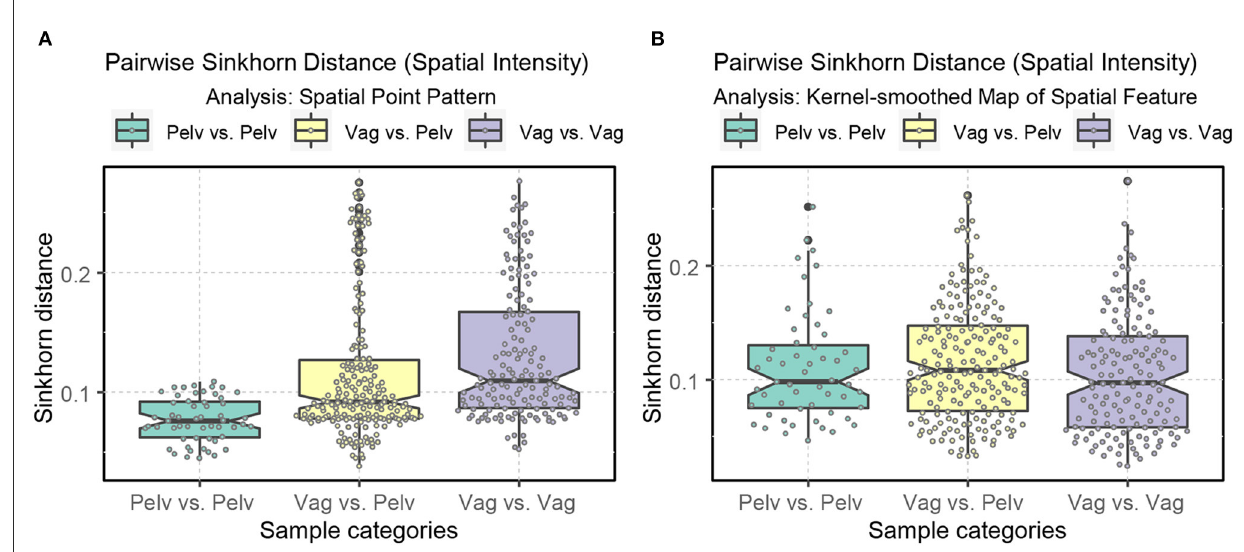
FIGURE13 Boxplots displaying the ranges of Sinkhorn distance between the spatial intensity of the nerve cross-sections. Pelv: pelvic; Vag: vagus. (A) Analysis of the spatial point patterns directly. (B) Analysis of the kernel-smoothed maps of the spatial features. The points show the individual Sinkhorn distances, revealing the hidden